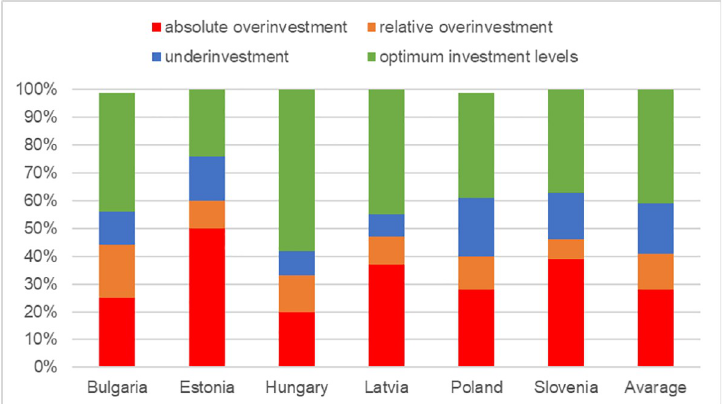
Fig 1. Structure of farms grouped by scale of investment (5). Source: own calculations based on unpublished EU-FADN–DG AGRI data.